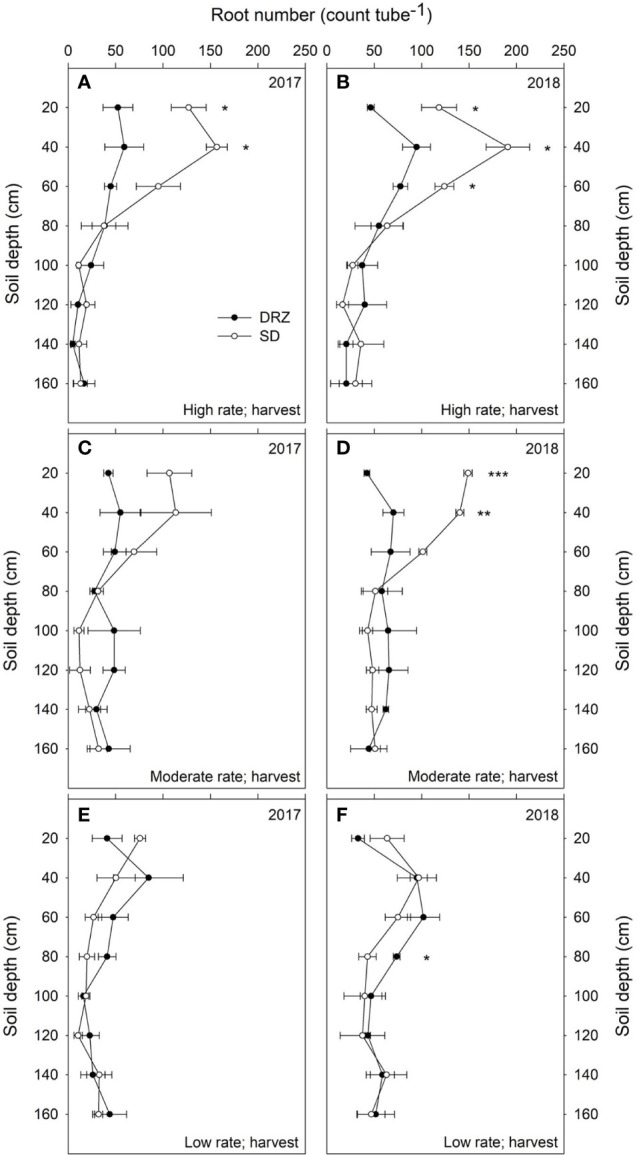
Total root number (count tube−1) along the 0-160 cm soil profile under surface drip (SD, open circles) and direct root-zone (DRZ, closed circles) irrigation at harvest in 2017 and 2018. Three irrigation rates were set based on crop evapotranspiration (ETc) for Cabernet Sauvignon: (A, B) high rate: 0.75–0.80 ETc; (C, D) moderate rate: 0.60–0.65 ETc; and (E, F) low rate: 0.45–0.50 ETc. *, ** and *** represent statistical differences at P ≤ 0.05, 0.01 and 0.001, respectively. Error bars represent standard error (n=3).